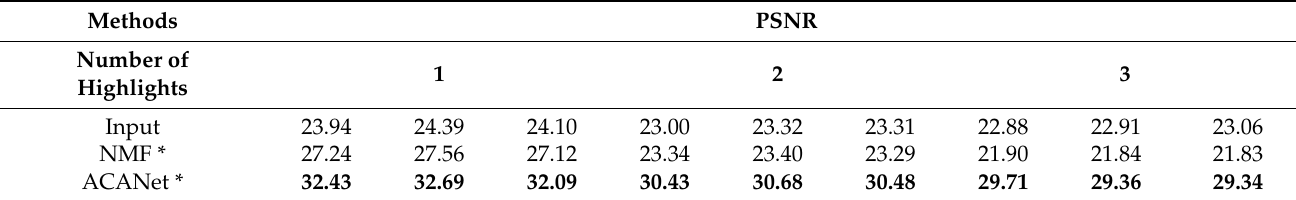
Table 4. Evaluation results of input signals with different numbers of